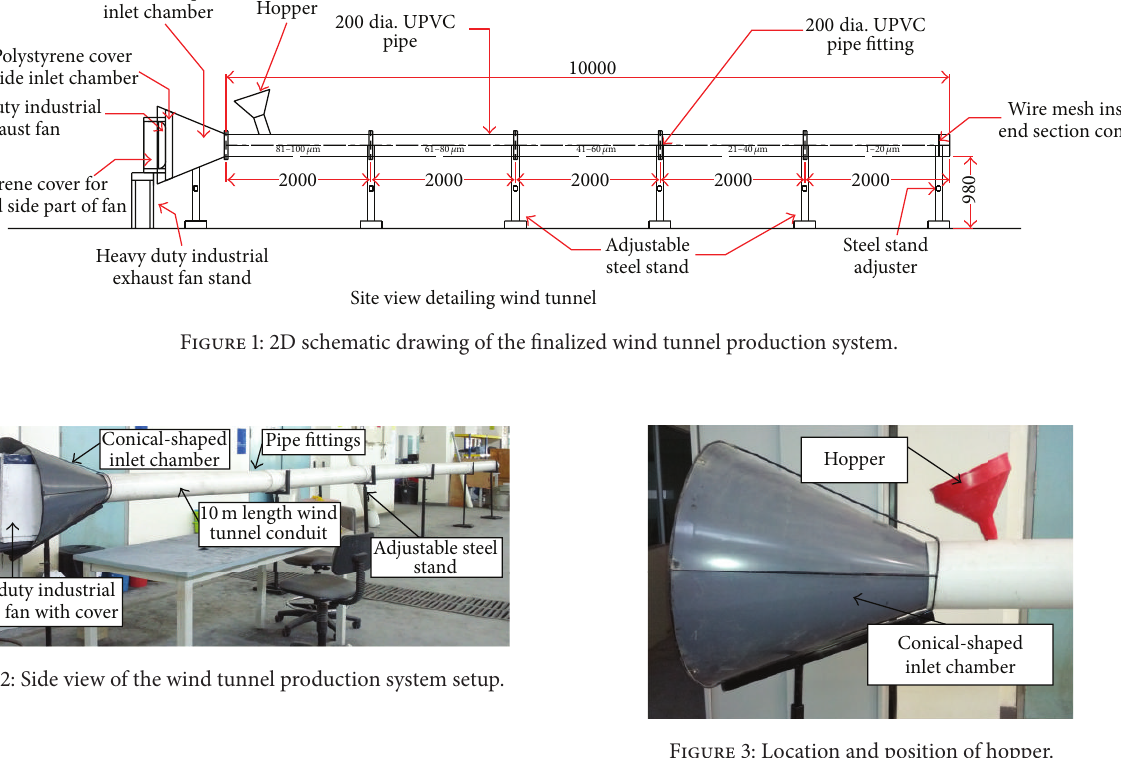
Figure 3: Location and position of hopper.